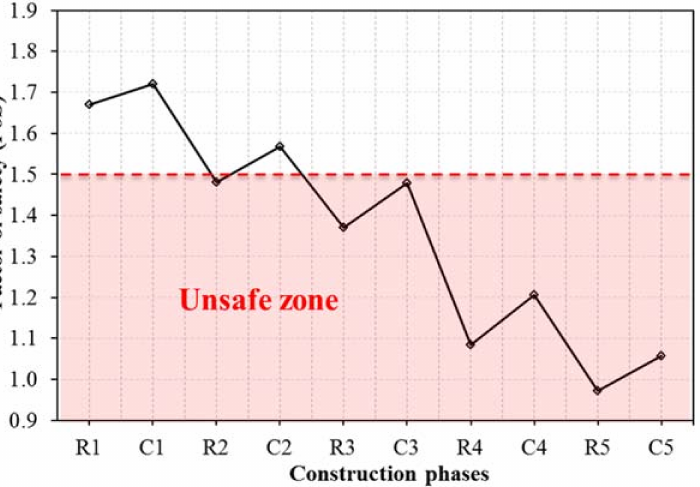
Figure 4. Factor of safety (filling rate of 5.0 m/year) during the pond filling comprising both raising phases (R) and consolidation phases (C).